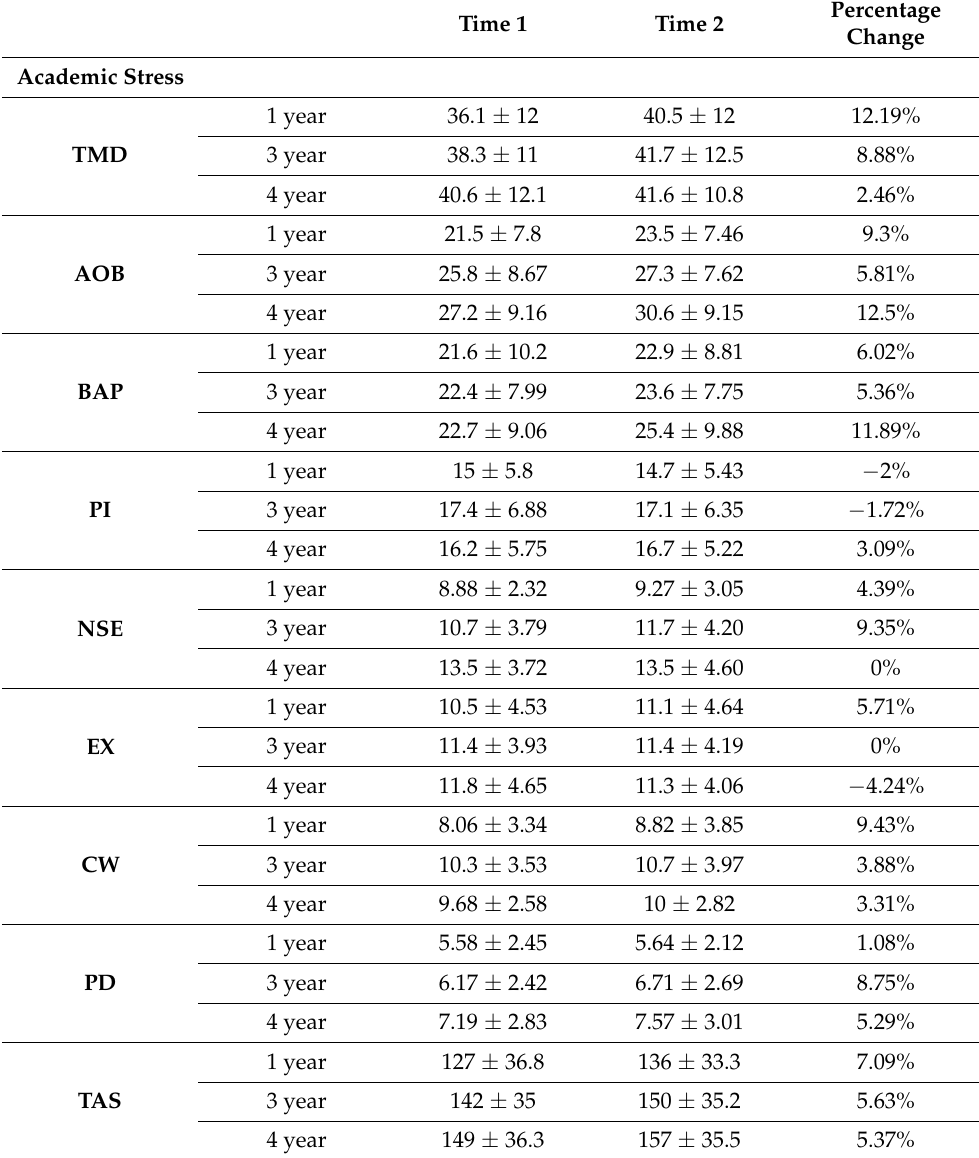
Table 5. Differences in academic stress in Time 1 (before lockdown declaration) and Time 2 (after lockdown) based on Year of study.